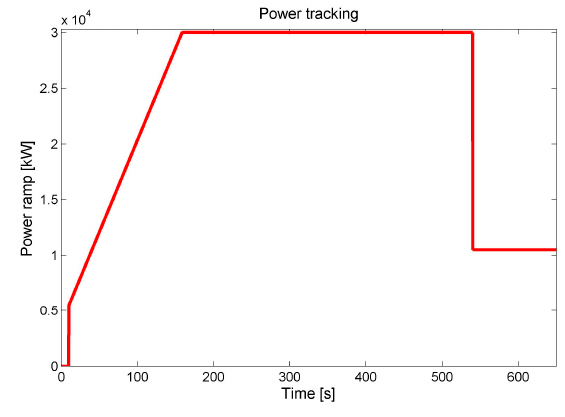
Figure 13. Power ramp reference.